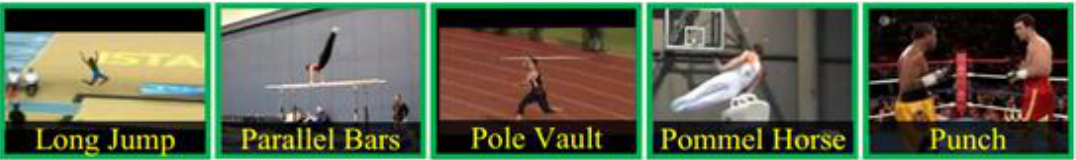
Figure 4. Sample frames from the UCF101